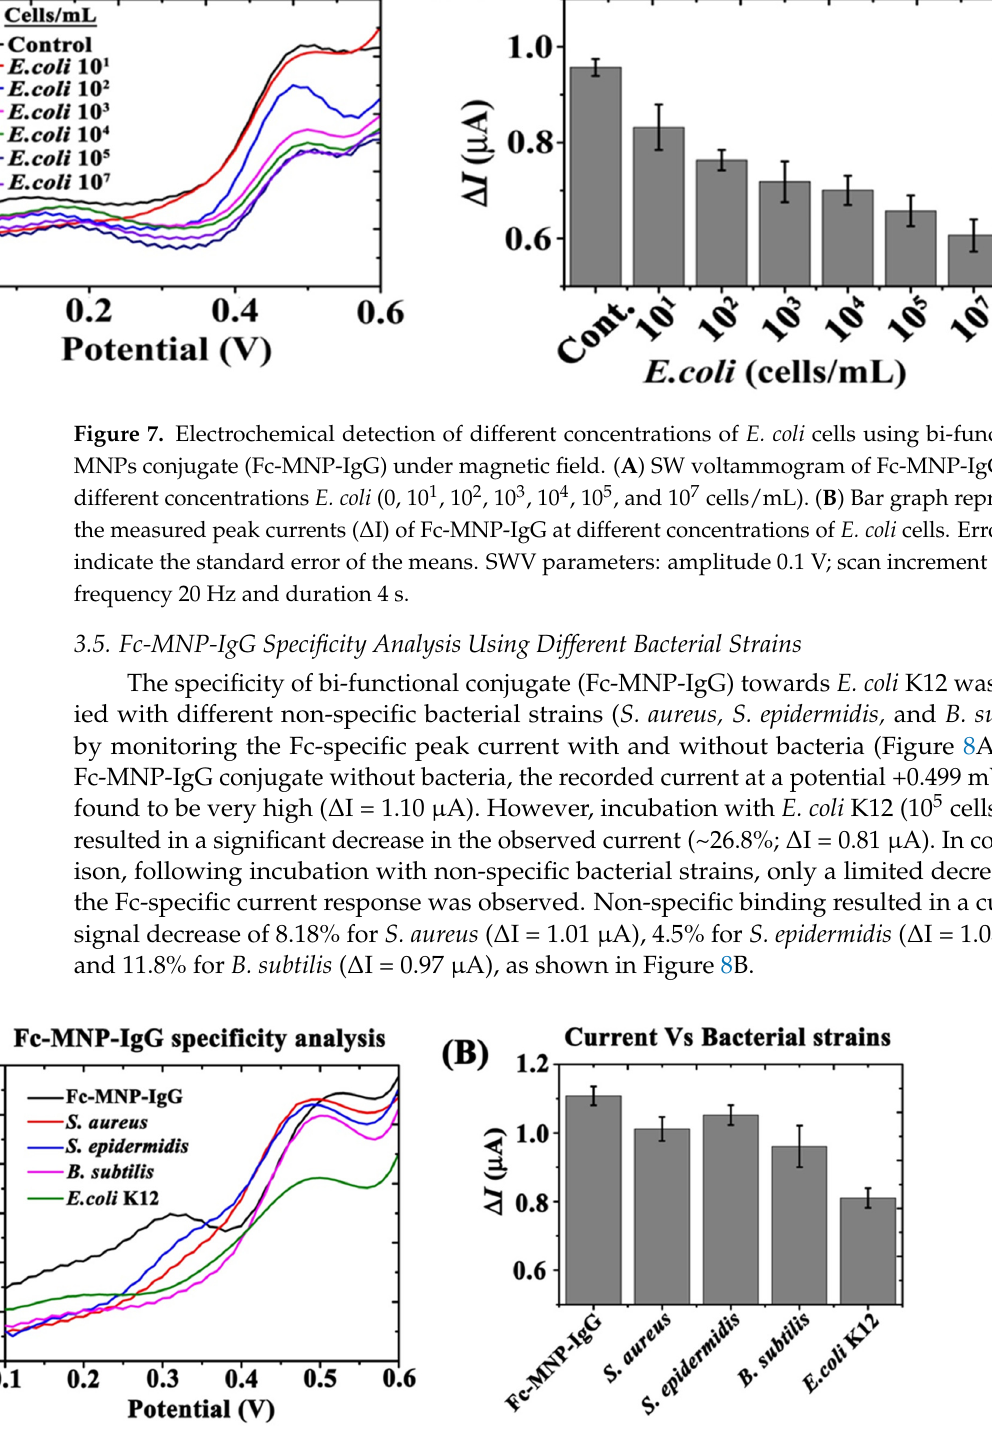
Figure 8. FC-MNP-IgG specificity analysis. SWV measurements were used to compare the E. coli K12 binding specificity with non-specific bacterial strains ( S. aureus , S. epidermidis and B. subtilis ). ( A ) SW voltammogram of Fc-MNP-IgG with different bacteria: E. coli K12, S. aureus , S. epidermidis and B. subtilis (10 5 cells/mL). ( B ) Bar graph represents the measured peak currents ( ∆ I) of Fc-MNP-IgG with the different bacteria. Error bars indicate the standard error of the means. SWV parameters: amplitude 0.1 V; scan increment 0.01 V; frequency 20 Hz and duration